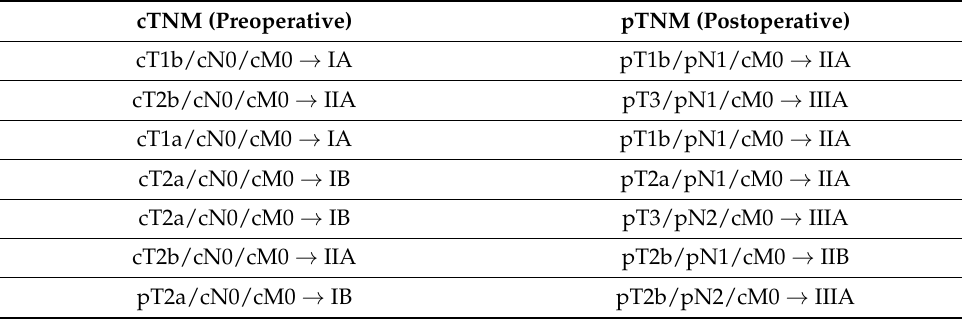
Table 8. TNM classification in group